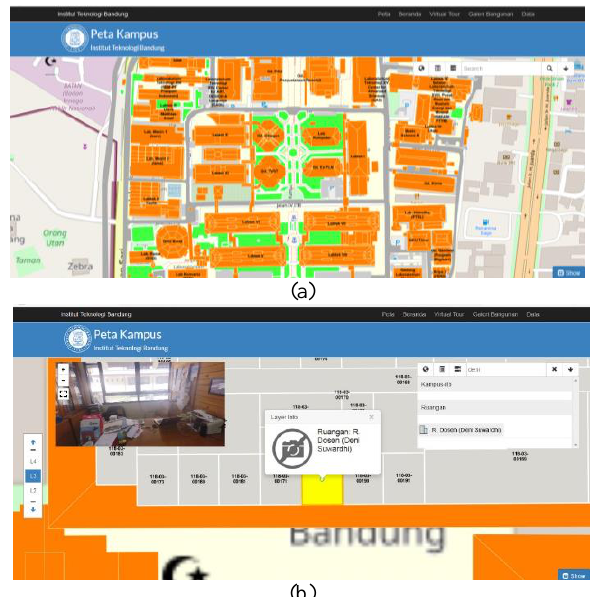
Figure 5. Web for public user: (a) 2D Map and (b) floor plan on each building with panoramic image for each room